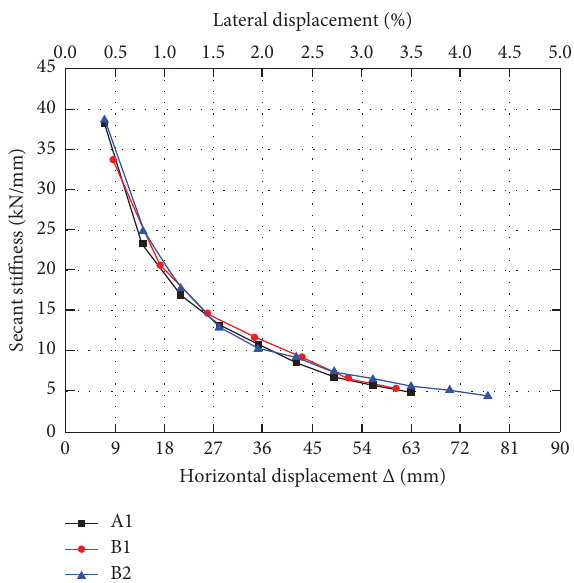
Figure 9: Stifness degradation curve of each